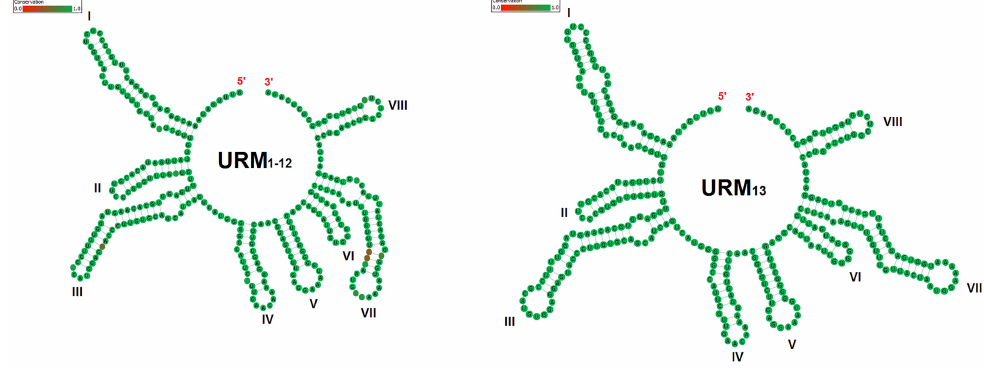
Fig. 6. Predicted secondary structure of ITS1 partial regions for Artemia urmiana based on two separated lineages by sequence-structure from profile neighbor-joining (See Fig.